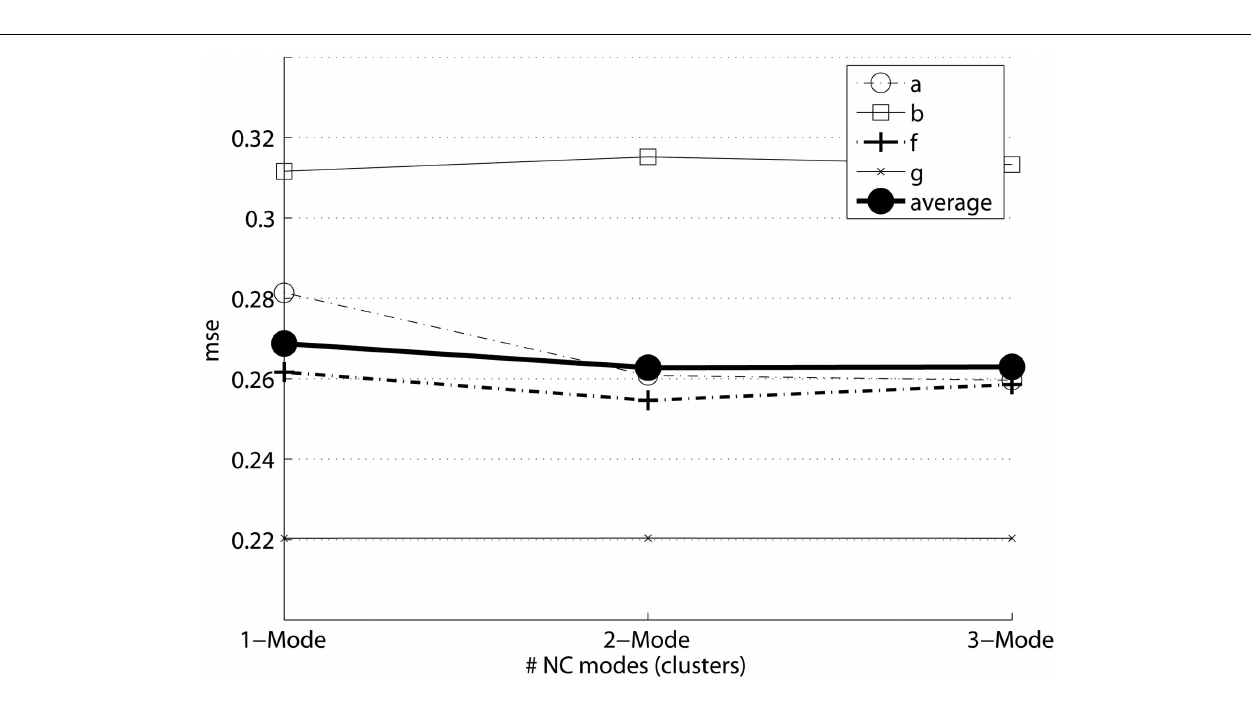
FIGURE 3 | MSE with respect to number of NC sub-states (modes) in